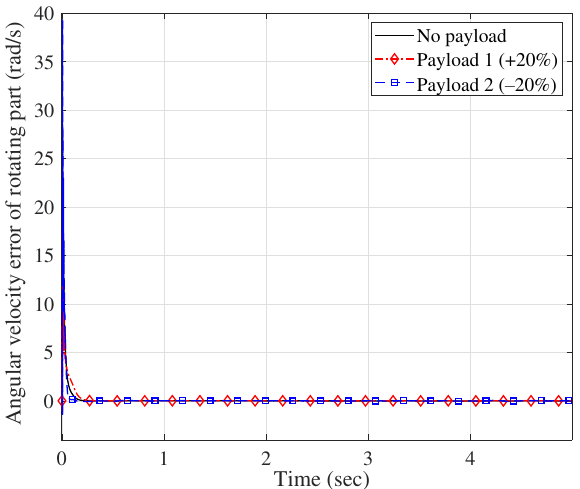
Figure 21. Angular velocity error of rotating part (Group